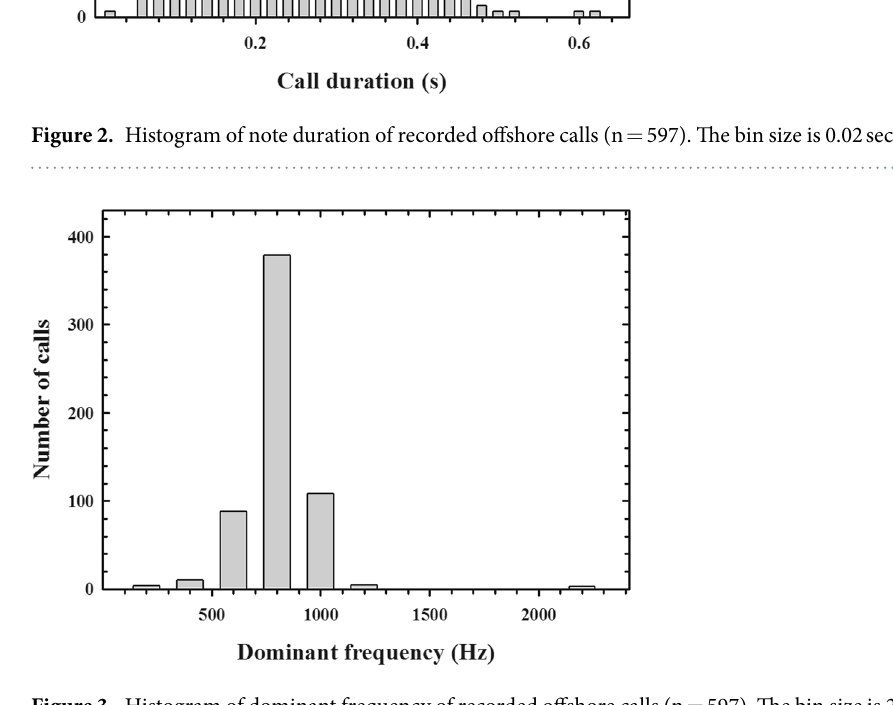
Figure 3. Histogram of dominant frequency of recorded offshore calls (n = 597). The bin size is 200 Hz.